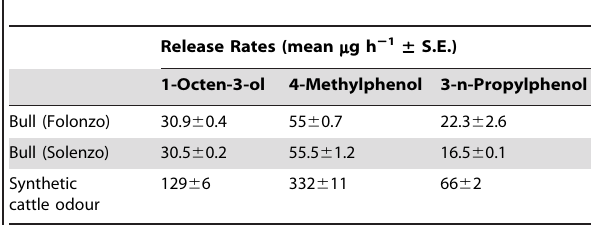
Table 5. Release rates of chemicals from natural and synthetic odour